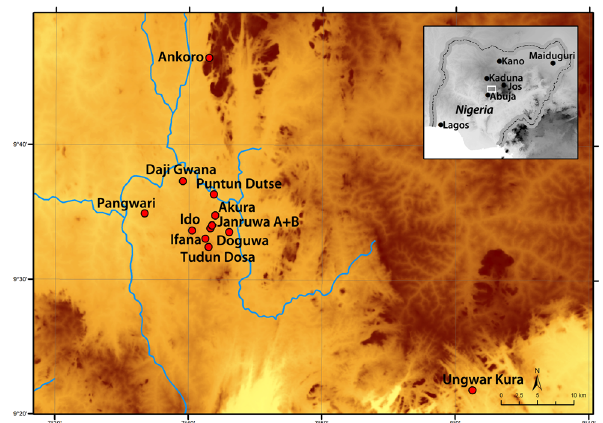
Fig. 1 Map of Nok sites. Distribution map showing Nok archaeological sites sampled in this study, including Akura, Ankoro, Daji Gwana, Doguwa, Ido, Ifana, Janruwa A, Janruwa B, Puntun Dutse, Pangwari, Tudun Dosa and Ungwar Kura (map by Eyub F.